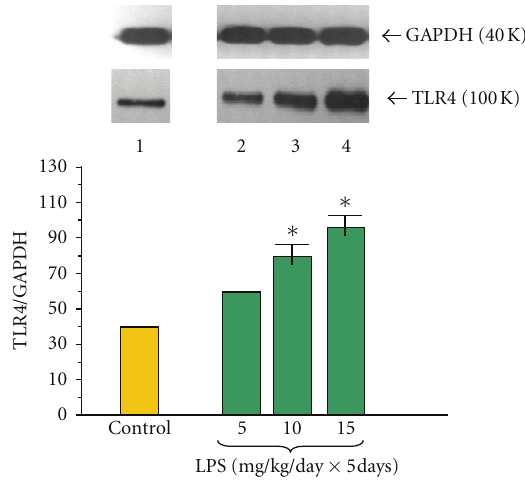
Figure 1: Western blot analysis of TLR4 protein level in the adult rat pancreatic acinar cells under basal conditions (lane 1), treated in the infant animals by lipopolysaccharide ( Escherichia coli ) at the doses of 5mg/kg/day × 5 days (lane 2), 10mg/kg/day × 5 days (lane 3), and 15 mg/kg/day × 5 days (lane 4) after 5 hours of incubation. Asterisk indicates significant ( P < 0 . 05) change, as compared to the control group. The blots were stripped and probed with GAPDH to document equal protein loading. All presented results were obtained in 4 consecutive experiments and are representative for the observed